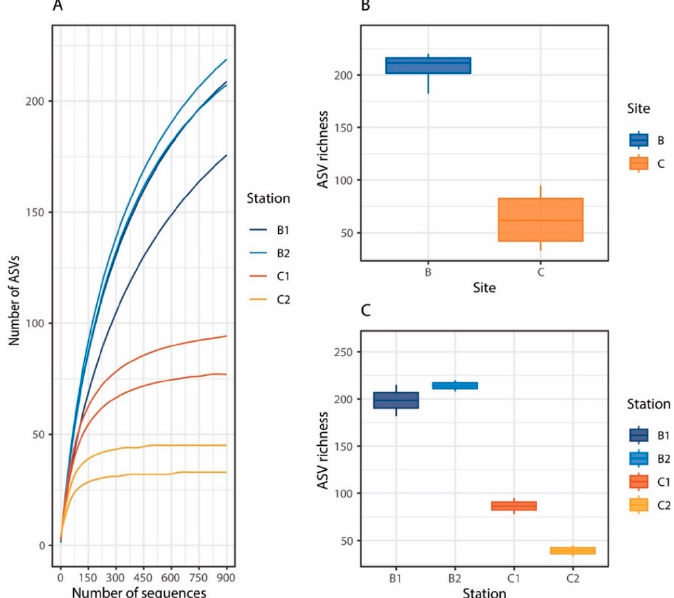
Figure 4. ( A ) Rarefaction curves from random subsampling (100 iterations) of 900 reads corresponding to the lowest read number obtained from the different sediment samples analyzed; ( B ) boxplot showing the fungal ASV richness in the two benthic deep-sea sites investigated, and ( C ) boxplot showing the fungal ASV richness in the four benthic deep-sea stations investigated.